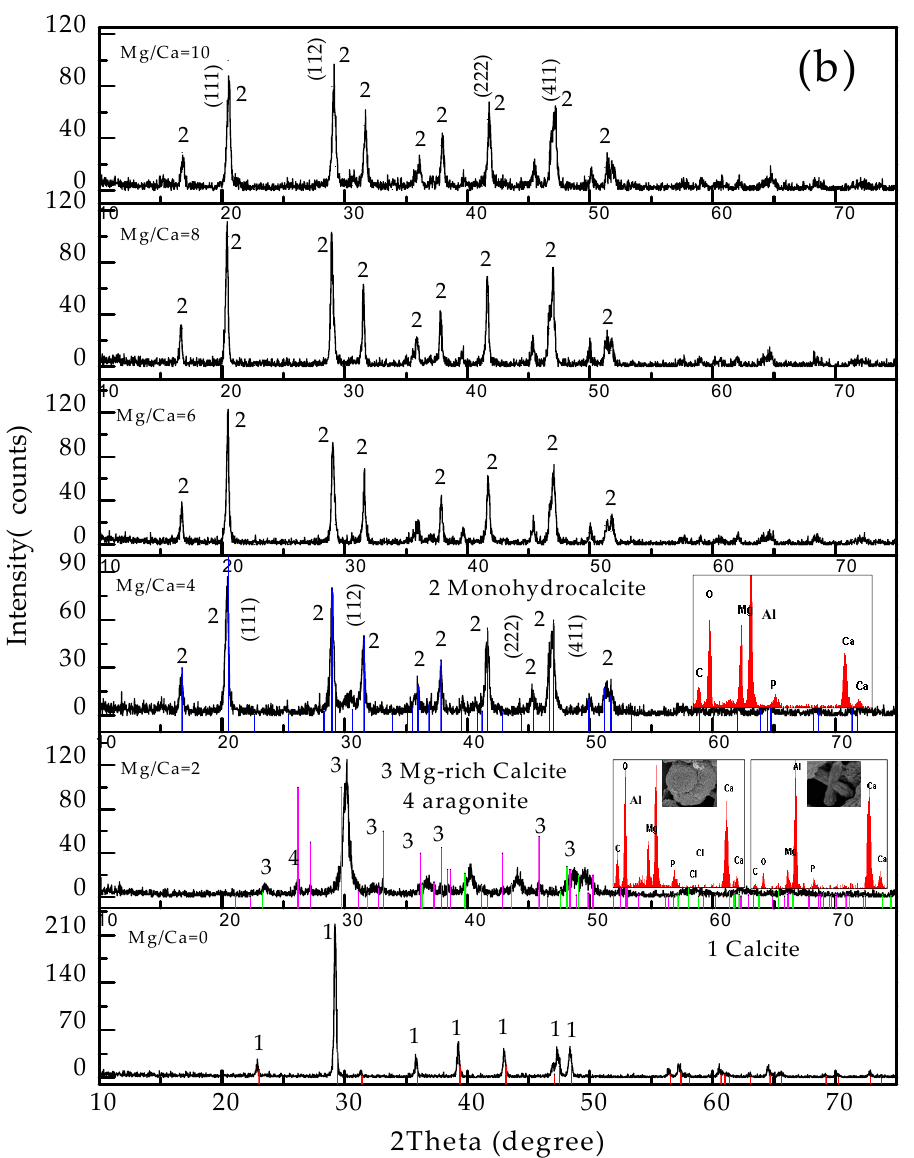
Figure 6. XRD patterns of the minerals at 15% NaCl and different Mg/Ca molar ratios in MgCl 2 aqueous solution after 15 days of cultivation: ( a ) the control group; and ( b ) the experimental group. Note: The red line represents the mineral phase of calcite in PDF card 47-1743, the blue line represents the mineral phase of monohydrocalcite in PDF card 29-0306, the green line represents the mineral phase of Mg-calcite in PDF card 43-0697, and the purple line represents the mineral phase of aragonite in PDF card 41-1475.